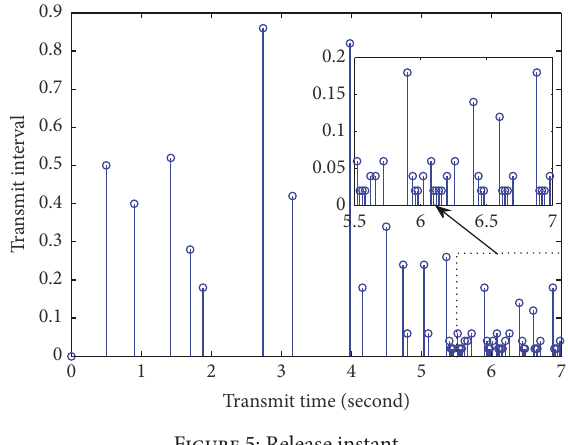
Figure 5: Release